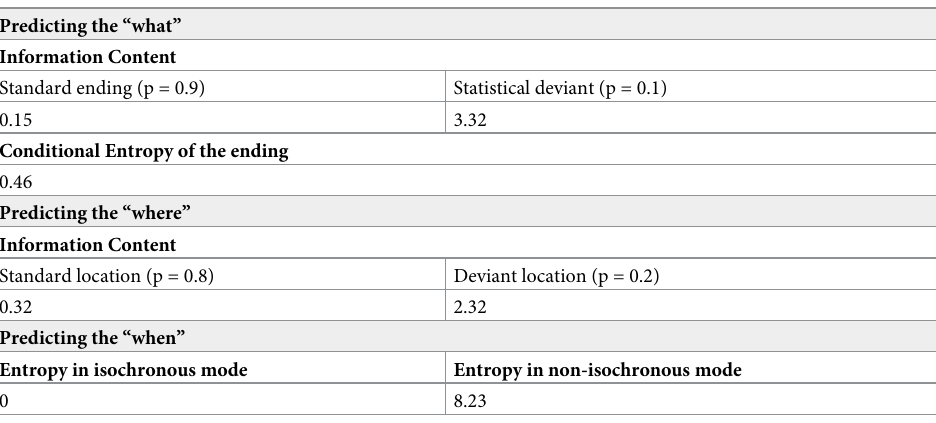
Table 3. Predictability values for triplet